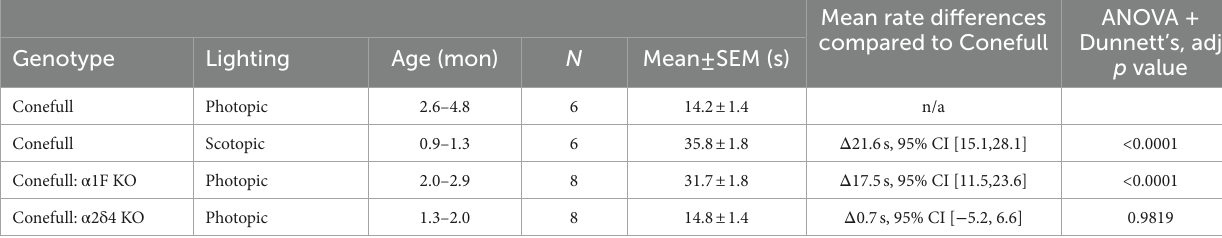
TABLE 1 Statistical description of visually guided water